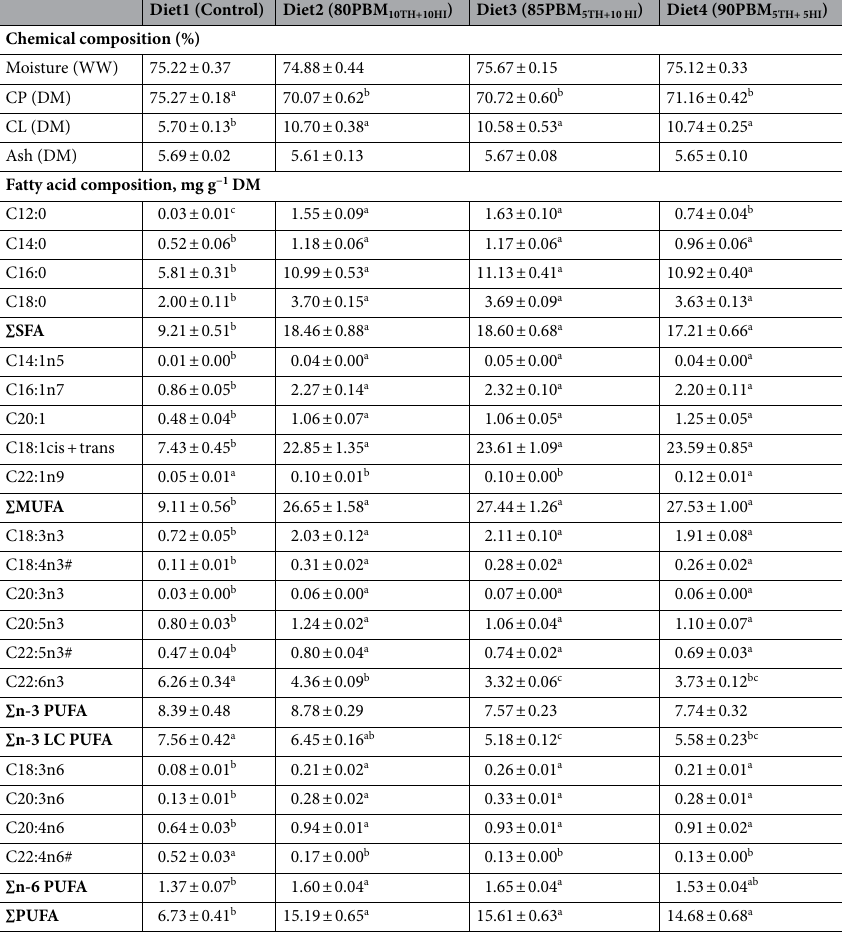
Table 5. Chemical composition and fatty acids composition (mg g -1 DM) of barramundi muscle (skin less) after six weeks feeding with a gradient PBM diets, concurrently supplemented with TH and HI larvae meal. Results are expressed as mean ± SE (standard error) (n = 12). Means with different superscripts letters in the same row indicates significant difference at P <